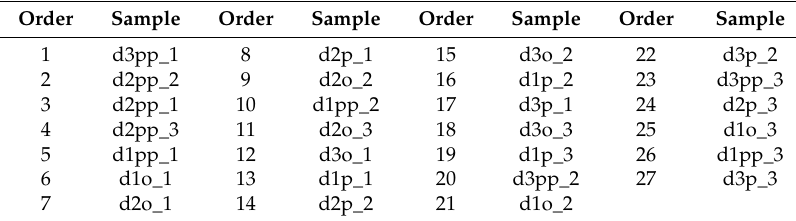
Table A3. Order of sample